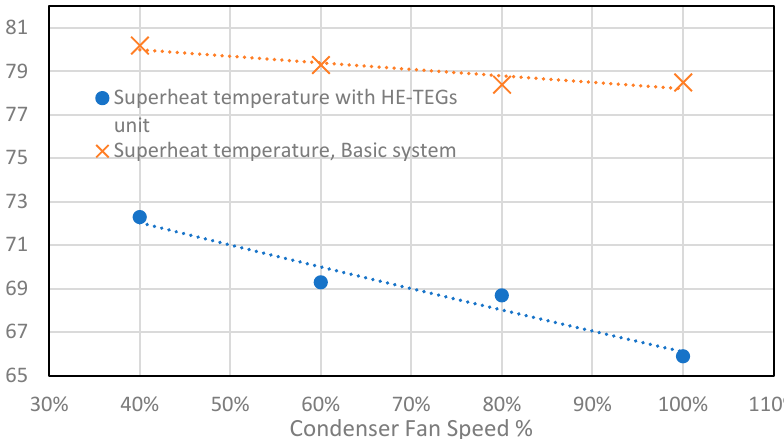
Figure 6. Variation of superheat temperature with condenser fan speed with and without HE-TEGs unit.